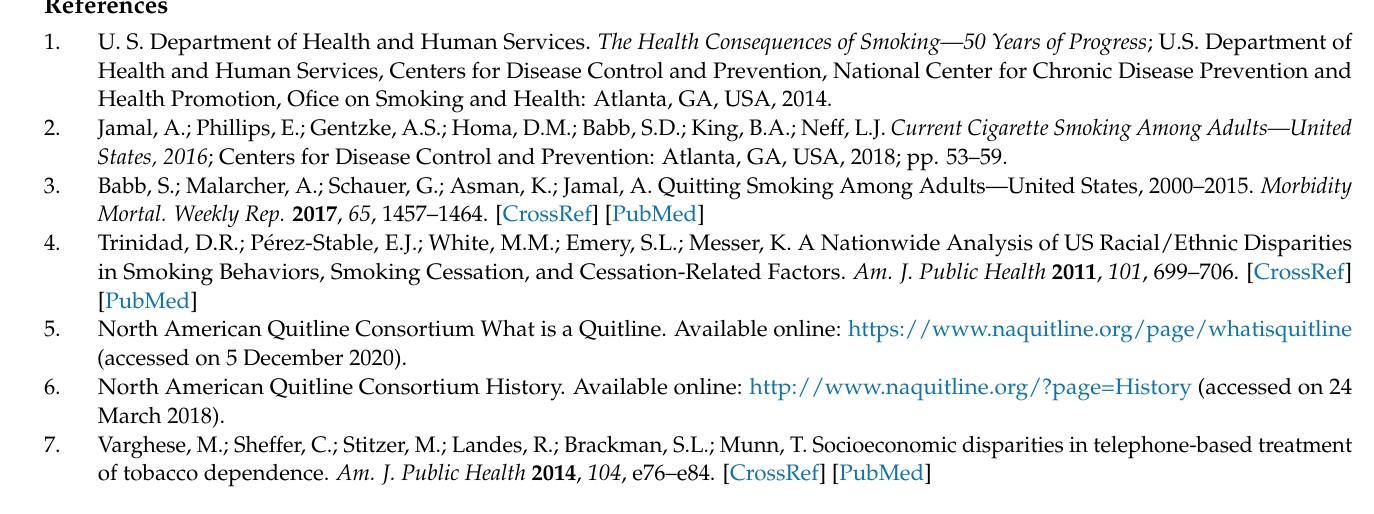
Figure A1. Predicted probability of 90-day smoking cessation associated with hours of counseling in the sample of year-ago smokers who had made a quit attempt, by education.